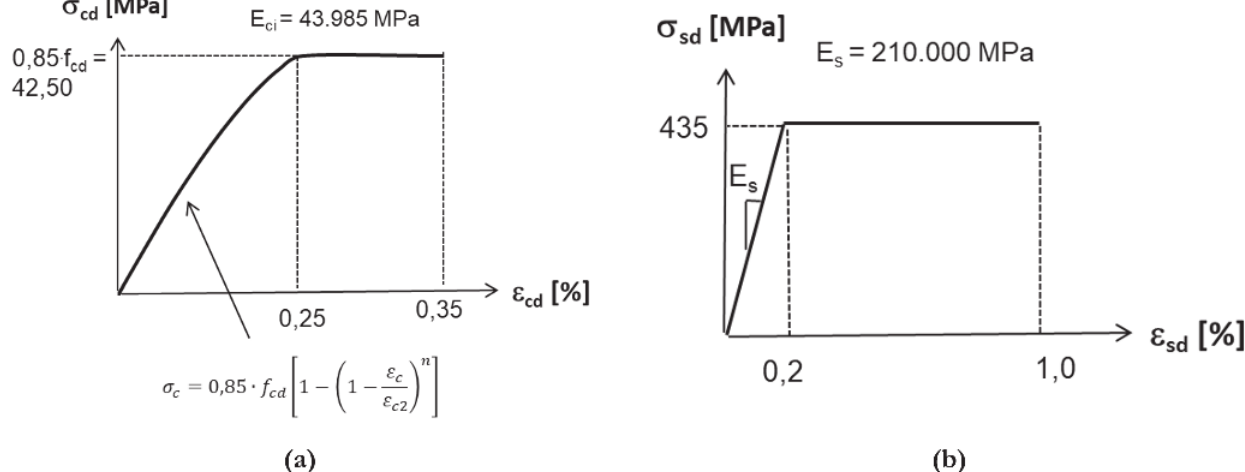
do comportamento à flexão (relação momento-curvatura) a partir da análise dos esforços atuantes na seção transversal do elemento es - trutural. A convergência é alcançada em cada nova etapa de cálculo (incremento da curvatura) através de variações da altura da linha neutra, determinando-se o momento resistente. Os dados de entra- da para o cálculo são as propriedades geométricas da seção e as propriedades mecânicas com as relações constitutivas dos mate - riais. As vantagens desse método são a sua simplicidade e eficácia para a verificação de elementos barriformes, com tensões atuantes em uma direção preferencial (estado plano de tensões).